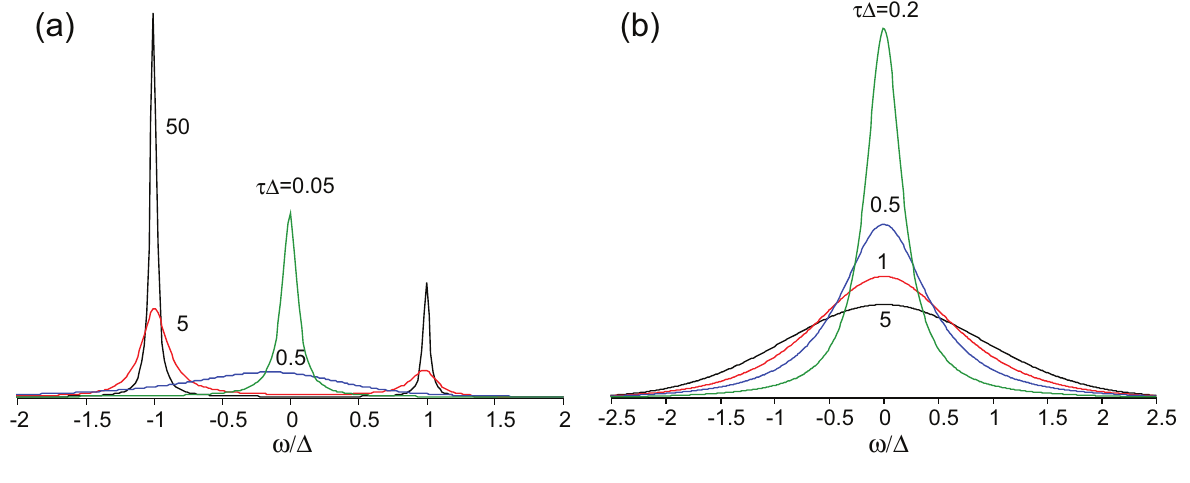
Figure 4. ( a ) Two-states-jump model calculated by Equation (3) with ω a = 10, and a = 0.3; ( b ) Gaussian model calculated using Equation (4). τ and Δ are the R P correlation time and amplitude of fluctuation,